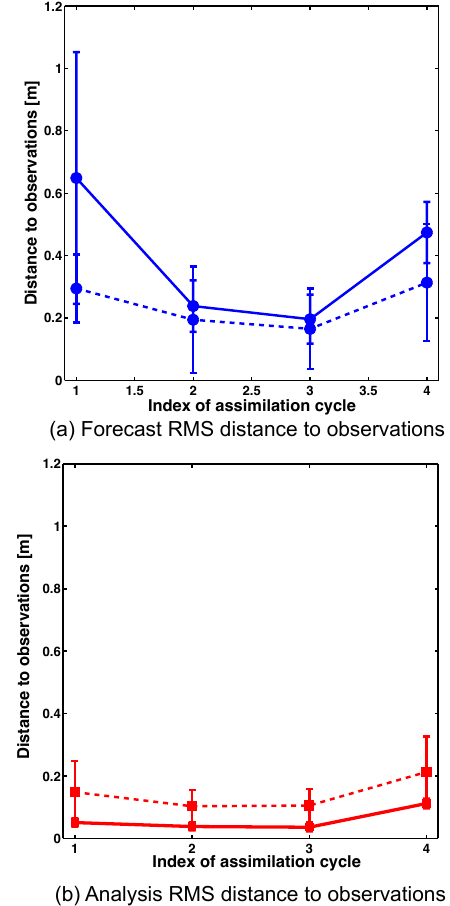
Figure 16. Evolution over 4 successive assimilation cycles of the average distance between the observations and the mean fire front location produced by the (a) forecast estimates and the (b) analy- sis estimates at times t 1 = 64s, t 2 = 78s, t 3 = 92s, and t 4 = 106s. Dashed (solid) lines represent PE (SE) results; vertical bars indicate the STD in the forecast and analysis